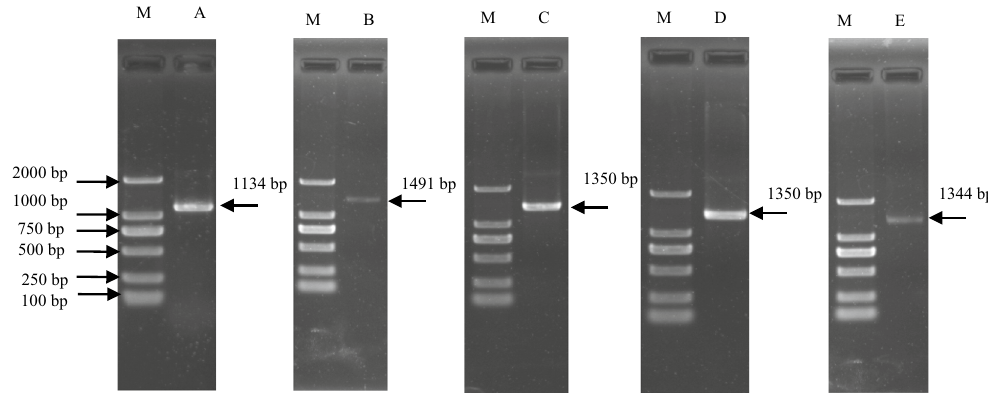
Figure 1. Agarose gel electrophoresis analysis of the ORFs for five reference genes in luffa. M: Marker 2000; A: ACT ; B: GAPDH ; C: TUA ; D: TUB ; E: EF-1α. The gels were cropped and the full-length gels were presented in Supplementary Fig. 1,